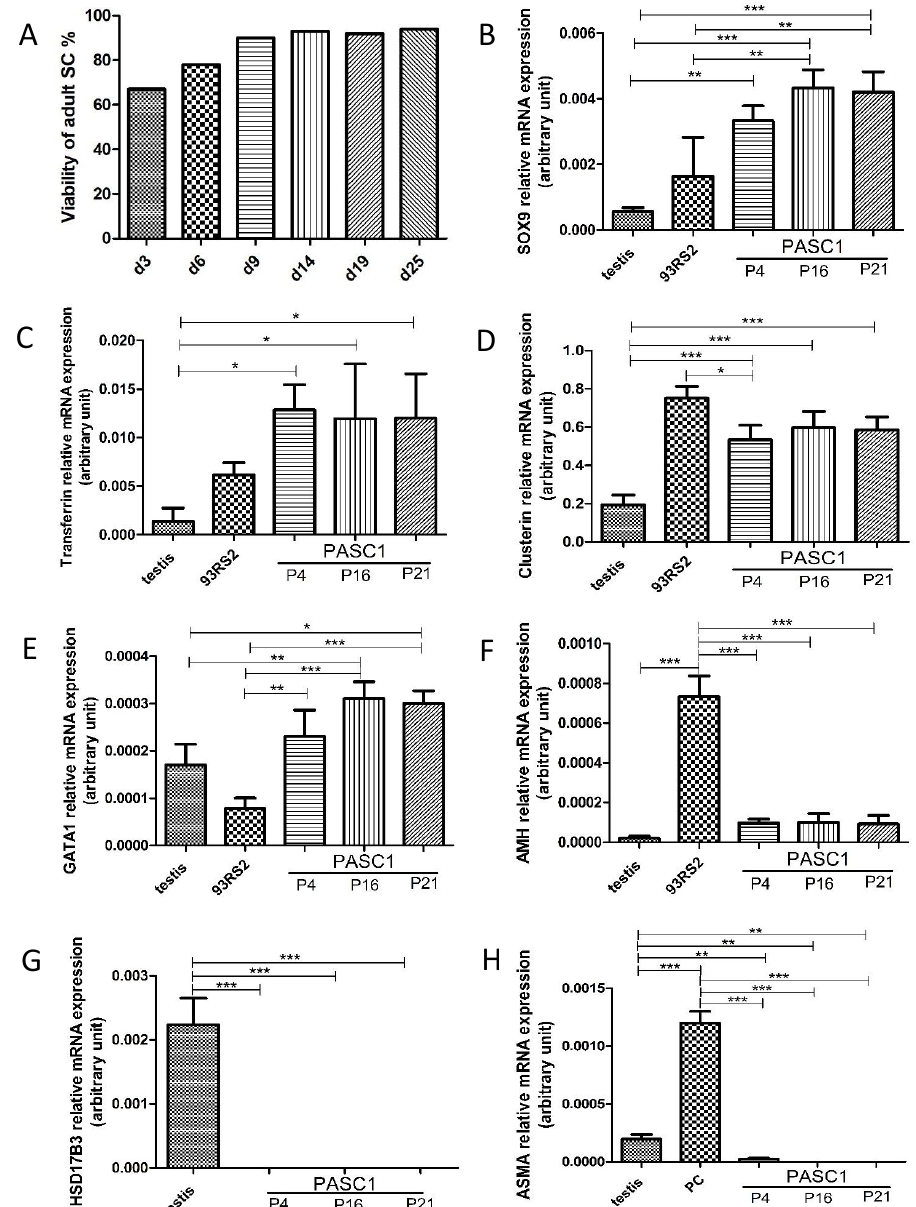
Figure 5. The viability of PASC1 increased strongly after 9 days (d9) of isolation from 63.5% at day 3 to 93% at day 25 ( A ). Gene expression of SC-specific and SC-maturation genes in passages 4 (P4), 16 (P16), and 21 (P21) was monitored with qRT-PCR. Immortalized immature rat 93RS2 SCs and adult rat testis were used as positive controls. In addition to a strong expression of SOX9 ( B ), transferrin ( C ), clusterin ( D ), and GATA1 ( E ), PASC1 showed a weak expression of AMH, a marker of immature SCs ( F ). Contamination of PASC1 by LCs was excluded using HSD17B3 ( G ) and by ASMA for PCs ( H ). Each bar represents the mean ± SEMs of three independent experiments performed in duplicates; * p ≤ 0.05; ** p < 0.01; *** p <